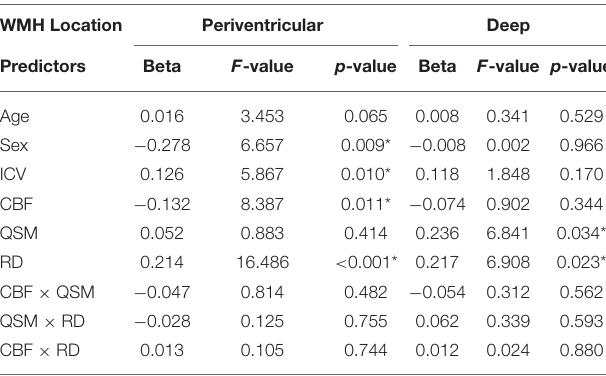
TABLE 4 | Summary of main effects and interactions of predictors on WMH volume in periventricular and deep regions.